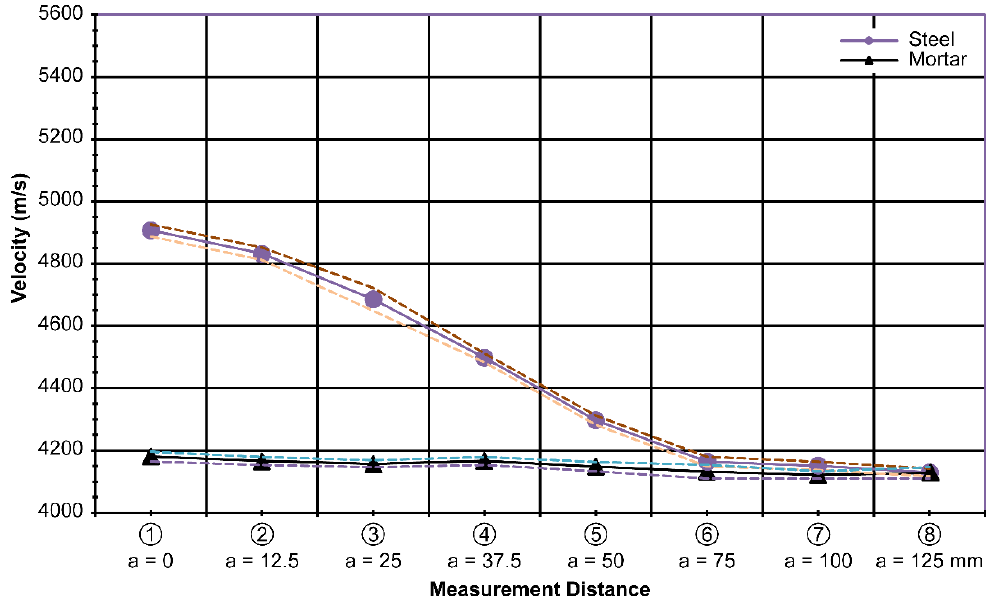
Table 1. ∆ V (m / s) for thickness variation at d = 75 mm and h = 150 mm. V  (m/s) for thickness variation at d = 75 mm and h = 150 mm. Steel Thickness Steel Thickness (mm)